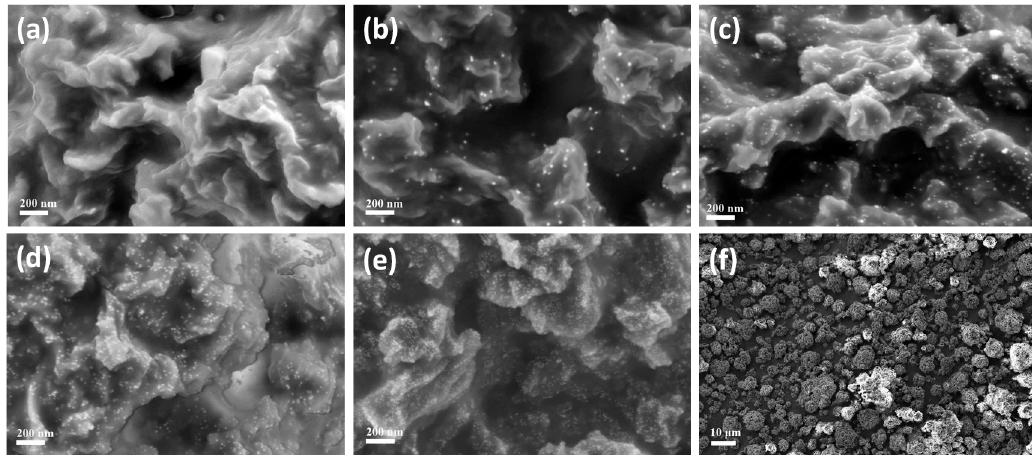
Figure 4. SEM images of the treated wool powders corresponding to different initial Au ion concentrations: ( a ) 0.2 mM; ( b ) 0.3 mM; ( c ) 0.4 mM; ( d ) 0.5 mM; and ( e , f ) 0.6 mM.